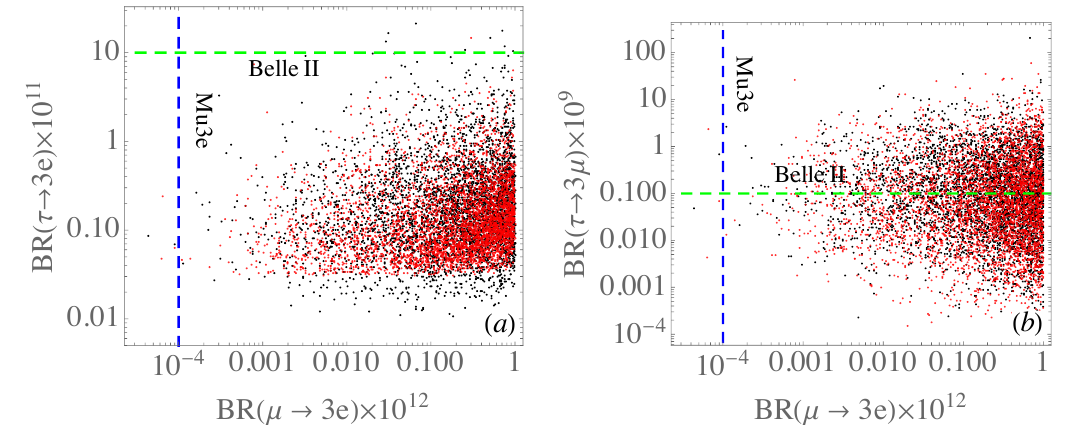
Figure 9 . Correlation of BR between µ → 3 e and (a) τ → 3 e and (b) τ → 3 µ . The black and red points denote the results of NO and IO,